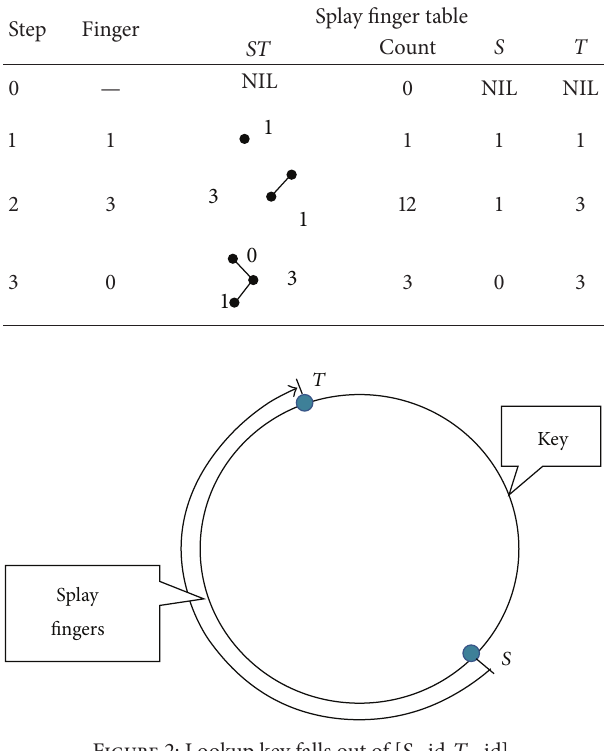
Figure 2: Lookup key falls out of [𝑆 ⋅ id ,𝑇 ⋅ id ]